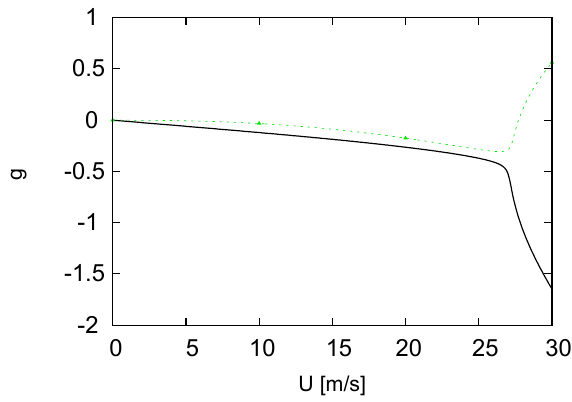
Fig. 8. The aerodynamic damping in dependence on the far field velocity U ∞ for the second considered aeroelastic problem. The results obtained by the linearized aerodynamical theory (solid line) and by the finite element method (symbols) are shown.